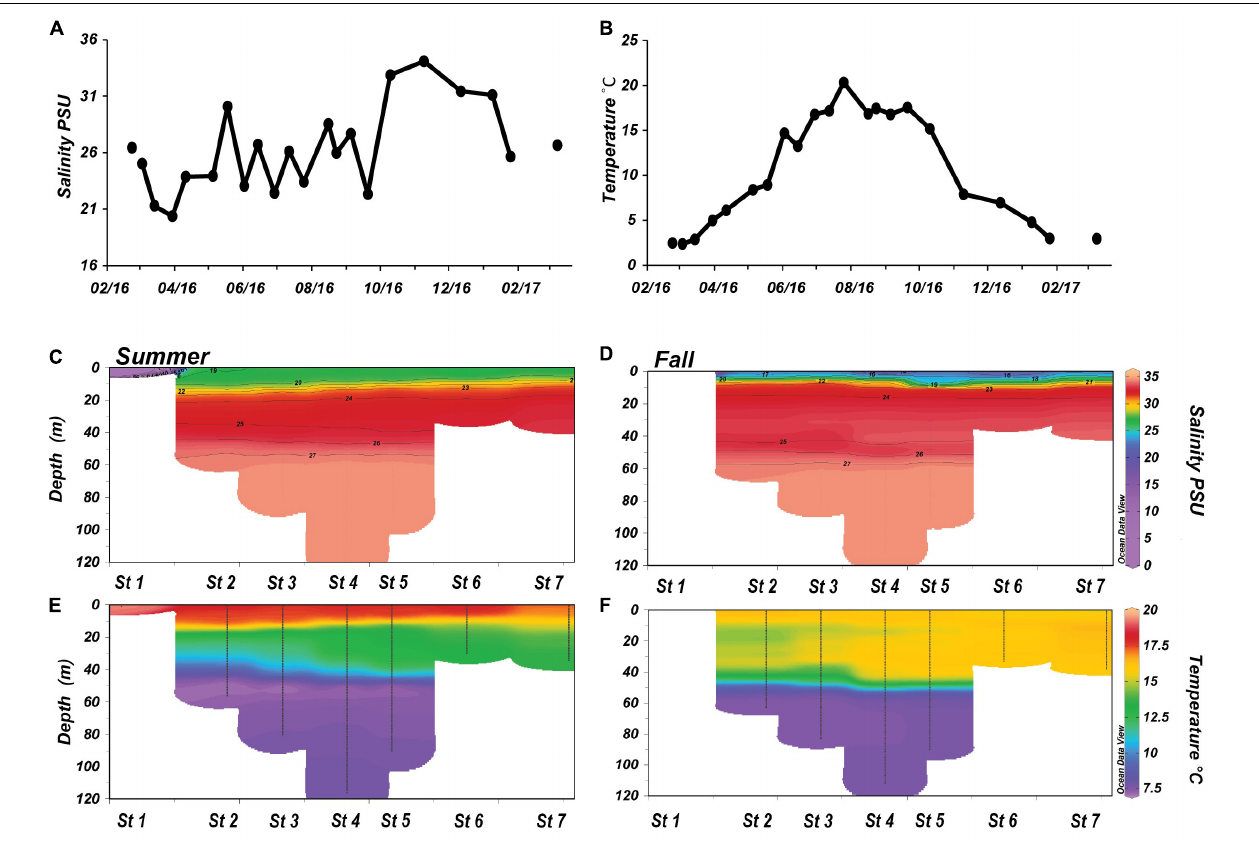
FIGURE 2 | Physical characteristics of Gullmar Fjord during 2016–2017 time series sampling and the summer (KB1707) and fall (KB1709) transect samplings. (A) Mean temperature ◦ C and (B) salinity measurements of the water column between 2 and 10 m over the duration of the time series sampling. (C,D) Salinity measurements of the whole water column during the transects. Superimposed over the salinities are contours of in situ density anomalies, revealing the stratification within the water column. (E,F) Temperature measurements of the whole water column during transect